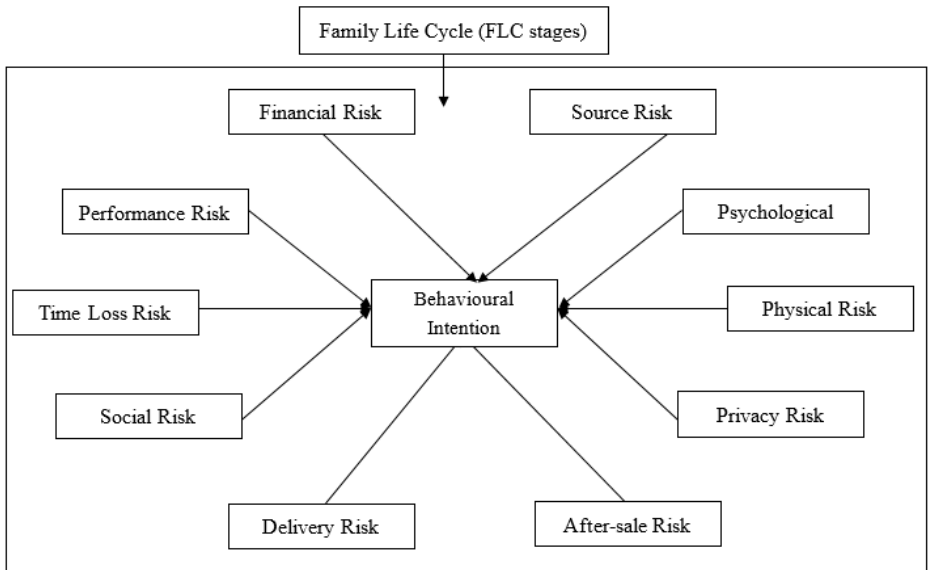
Figure 1. Proposed Research Model.